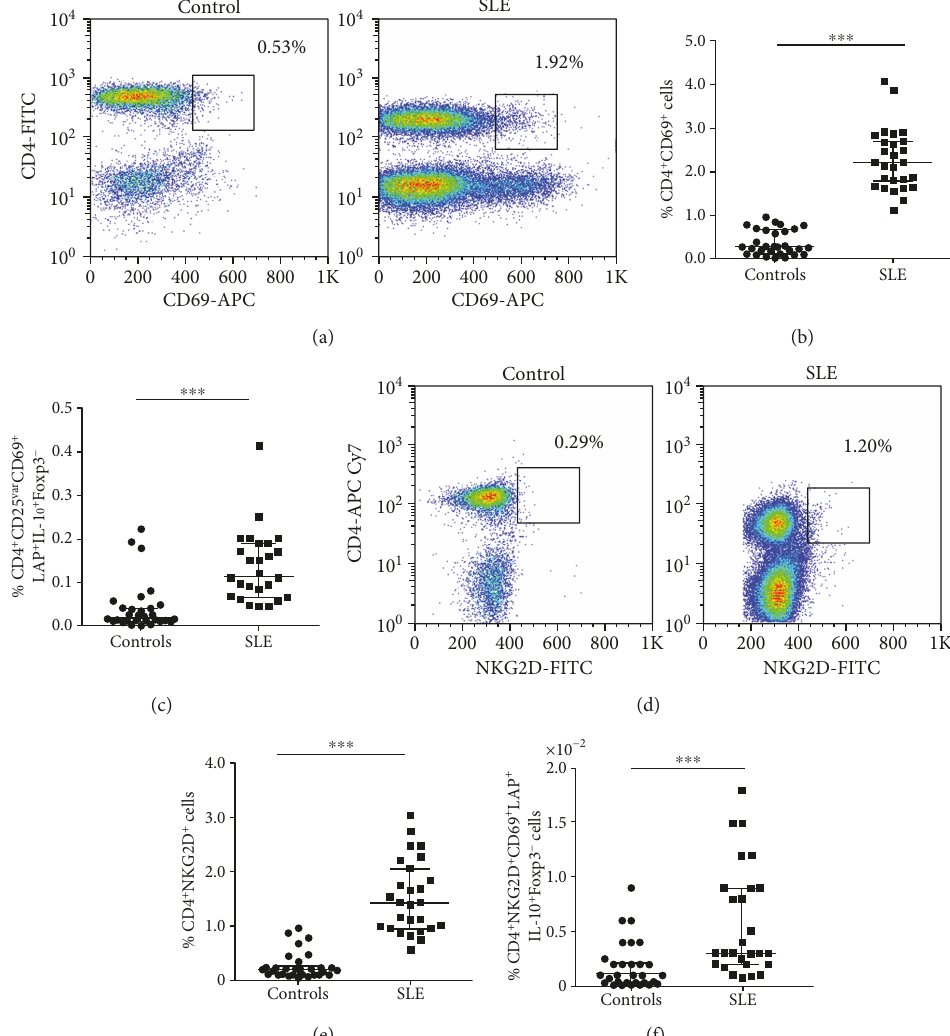
Figure 2: Levels of CD69 + Treg cells in peripheral blood from patients with SLE and healthy controls. The frequency of CD69 + Treg cells was determined in freshly isolated PBMC from patients with SLE and healthy controls by multiparametric fl ow cytometry, as indicated in Materials and Methods. (a) Representative dot plots of a CD4 + CD69 + cells from a healthy control and a patient with SLE. (b) Percent of CD4 + CD69 + cells. (c) Percent of CD4 + CD25 var CD69 + LAP + IL-10 + Foxp3 − cells. (d) Representative dot plots of CD4 + NKG2D + cells from a control and patient with SLE. (e) Levels of CD4 + NKG2D + cells. (f) Frequency of CD4 + CD69 + NKG2D + LAP + IL-10 + Foxp3 − Treg cells. In all cases, the percentages of positive cells are referred to total lymphocytes. Horizontal lines correspond to the median and interquartile range. ∗∗∗ p < 0 05